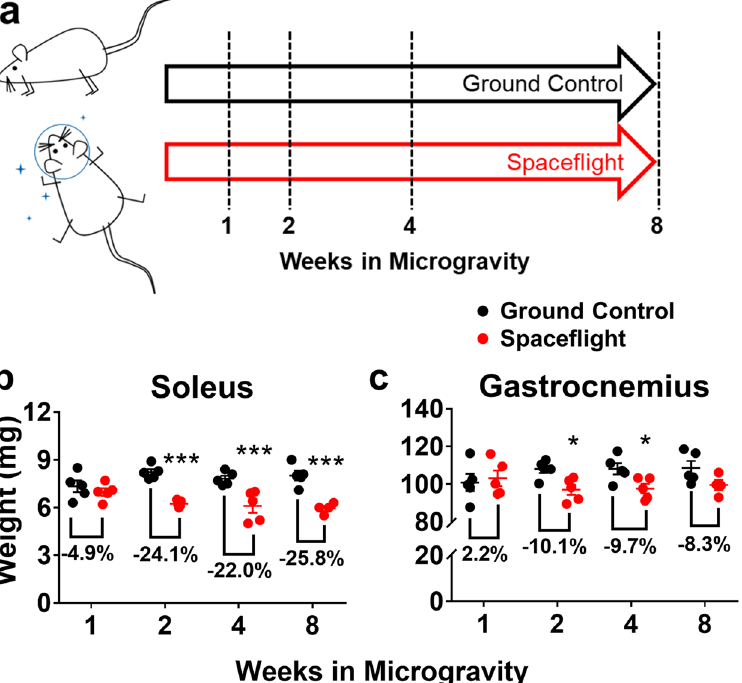
Figure 5. Time course of microgravity induced muscle atrophy. ( a ) Graphic representation of study design depicting mice subjected to 1, 2, 4 or 8 weeks of microgravity. ( b ) Mice present with significant soleus muscle loss after 2, 4 and 8 weeks of microgravity exposure. ( c ) Gastrocnemius shows marginal loss of mass after 2 and 4 weeks of microgravity only. Data are presented as means ± SEM (n = 4–5/group). * p < 0.05, *** p < 0.001, Spaceflight vs. corresponding Ground Control by unpaired t-test.